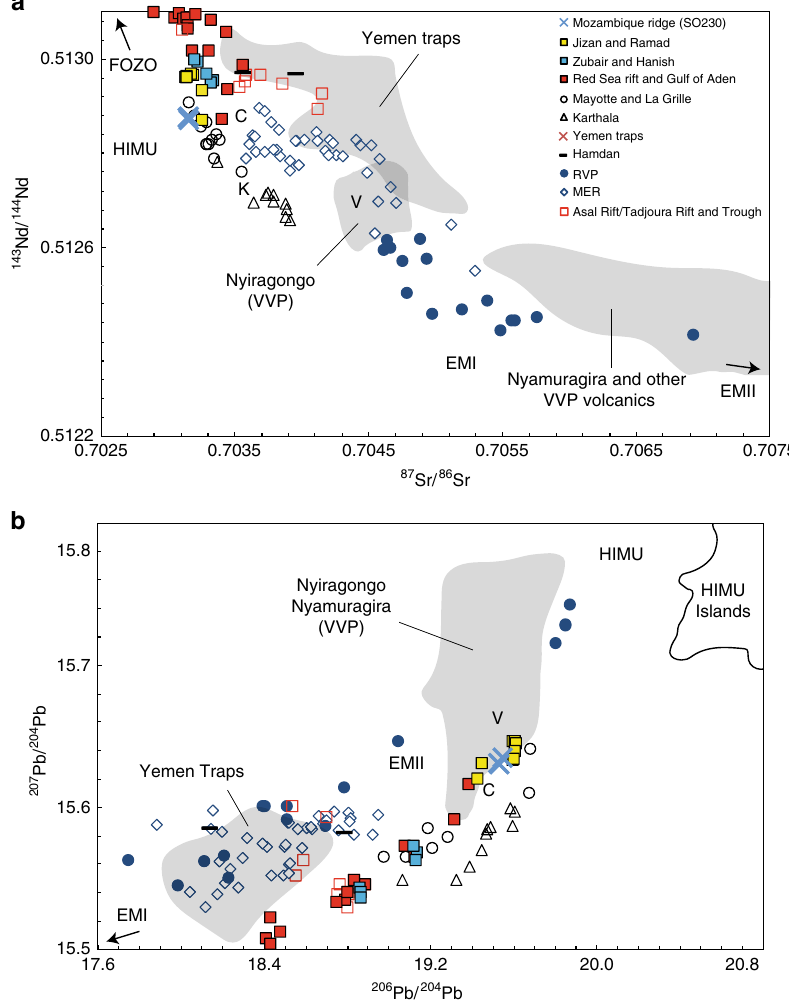
Fig. 5 Radiogenic isotope characteristics. a 143 Nd/ 144 Nd vs. 87 Sr/ 86 Sr and b 206 Pb/ 204 Pb vs. 207 Pb/ 204 Pb for Mozambique Ridge OIB samples and lavas from the MER, RVP, Comoro Islands, Red Sea-Gulf of Aden. Lavas from Nyiragongo and Nyamuragira volcanoes in the Virunga Volcanic Province (VVP) and the Yemen Traps are shown as a grey shaded fi eld. EMI, C, FOZO, EMII, BSE and HIMU are proposed mantle endmembers 106,107 . V, K, and C are the proposed Virunga (ref. 21 , modi fi ed from ref. 54 ), Kenyan 18 and Afar 20 mantle plumes, respectively. Note that V and C have the approximately the same 206 Pb/ 204 Pb values. The range of ‘ classic' HIMU islands is de fi ned by the St. Helena and the Cook – Australs; data from the GEOROC database (http://georoc.mpch-mainz. gwdg.de/). Data for the Tadjoura Trough, Tadjoura Rift and Asal Rift from ref. 52 . Other data sources as in Fig. 4. Figure adapted from ref. 21